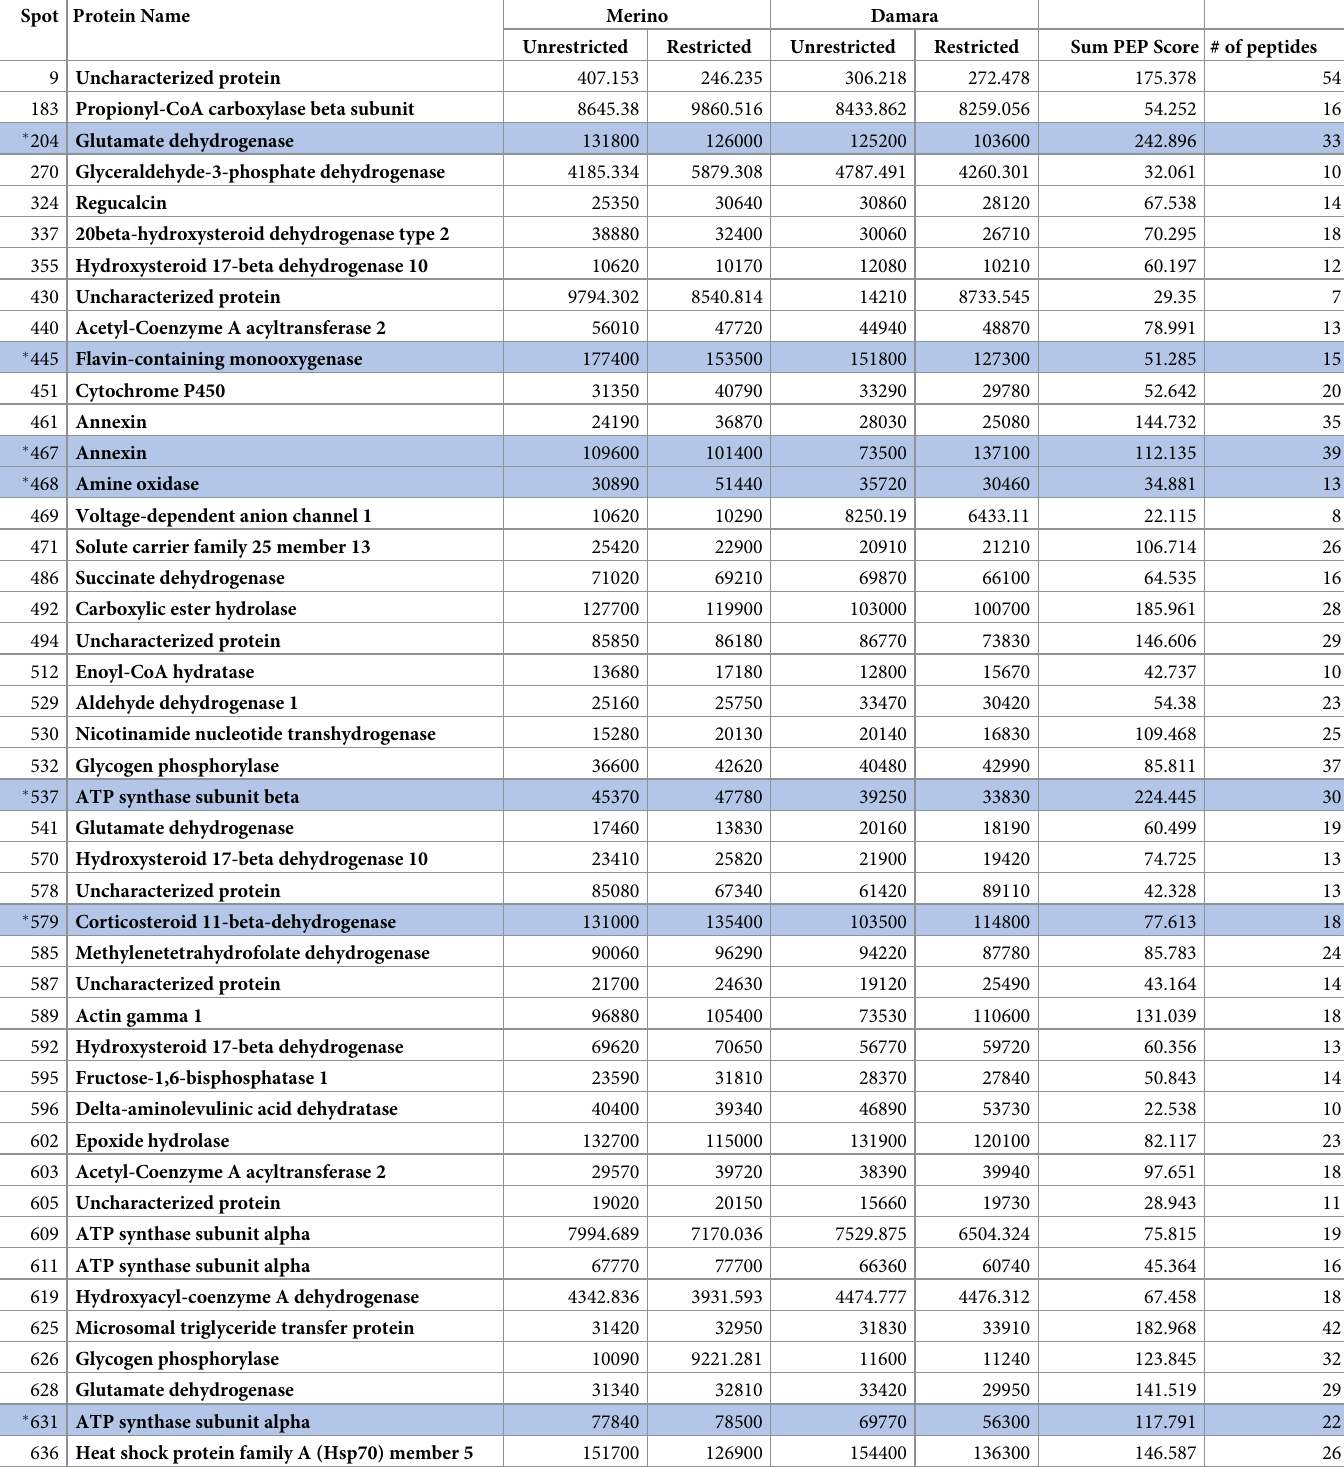
Table 1. Hepatic mitochondrial proteome compiled from each of the 6 replicates by sheep breed and diet as determined via 2D-BN/SDS-PAGE coupled to LC-MS/ MS. Spot Protein